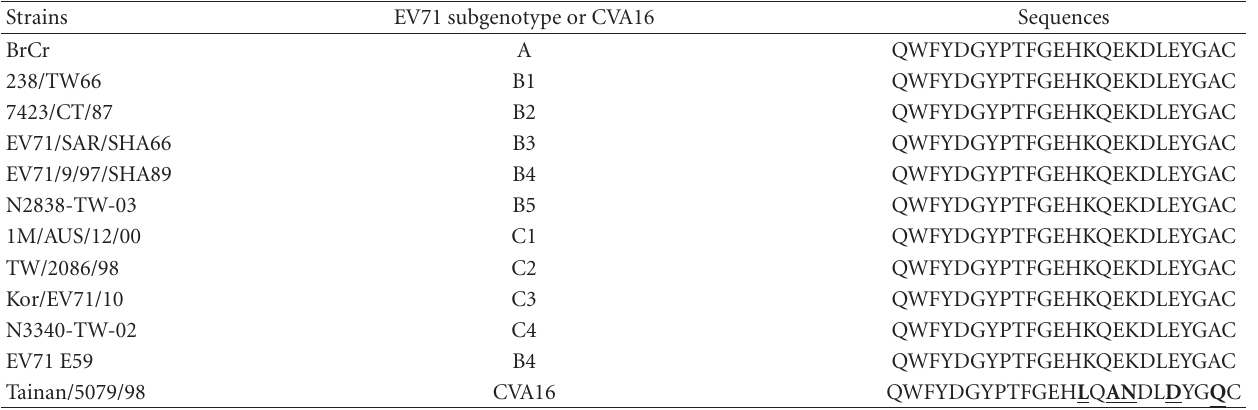
Table 3: Alignment of VP1 amino acid (200–225) sequences from di ff erent EV71 subgenotypes and CVA16. Strains EV71 subgenotype or